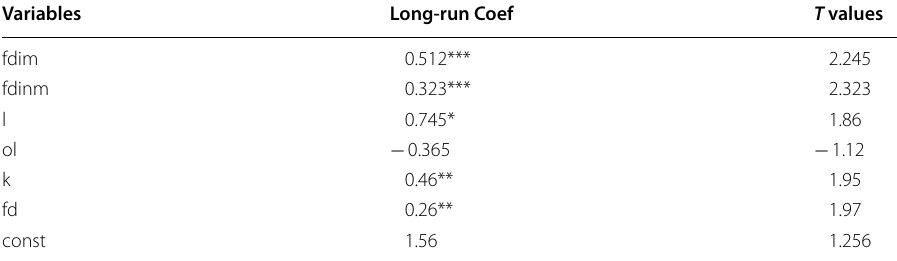
We alternatively used GDP per capital as our dependent variable and the results obtained are consistent on the overall * Is significance at 10%; ** at 5% and *** at 1%, respectively. Ramsey RESET test {residual squares/functional form}: F Breusch–Pagan heteroscedasticity: Chi-square LM test: